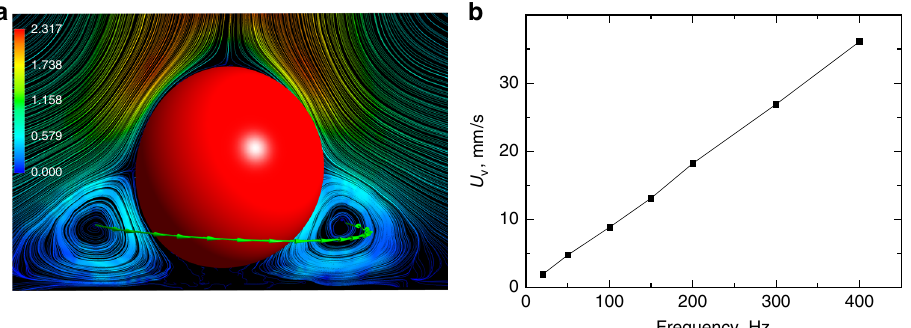
Fig. 4 Stagnation zone. a A stagnation zone formed by a sphere rotating around an axis perpendicular to a plane: stream surfaces in a plane containing the rotation axis for f = 400 Hz, radius of the particle a = 30 μ m. Velocity is measured in mm s − 1 . b Magnitude of the vortex velocity U v